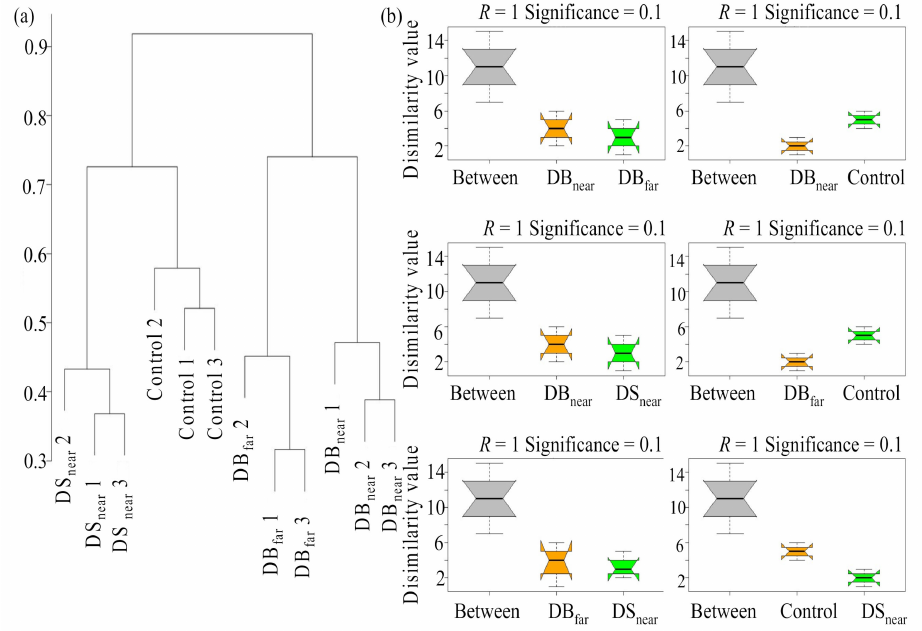
Figure 4. The clustering analysis ( a ) and similarities (ANOSIM) test ( b ) of the four fungal communities (i.e., DB near , DB far , DS near , and Control) based on the normalized database of OTUs. The introduction of DB near , DB far , DS near , and Control, as suggested in Figure